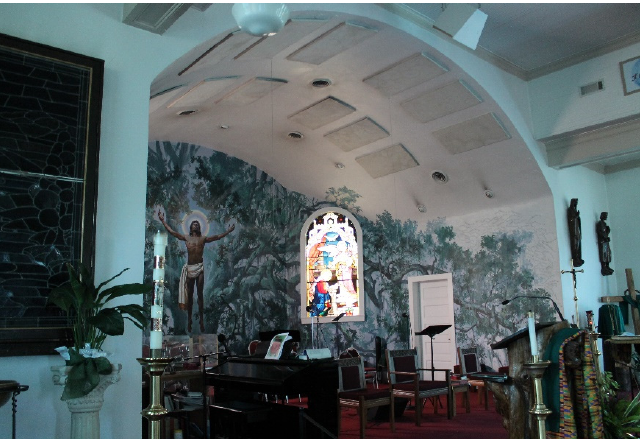
Figure 12. Mural of “Christ In the Oaks”, Saint Rose Catholic Church, Bay Saint Louis, Mississippi. Image by the author. August 2020.